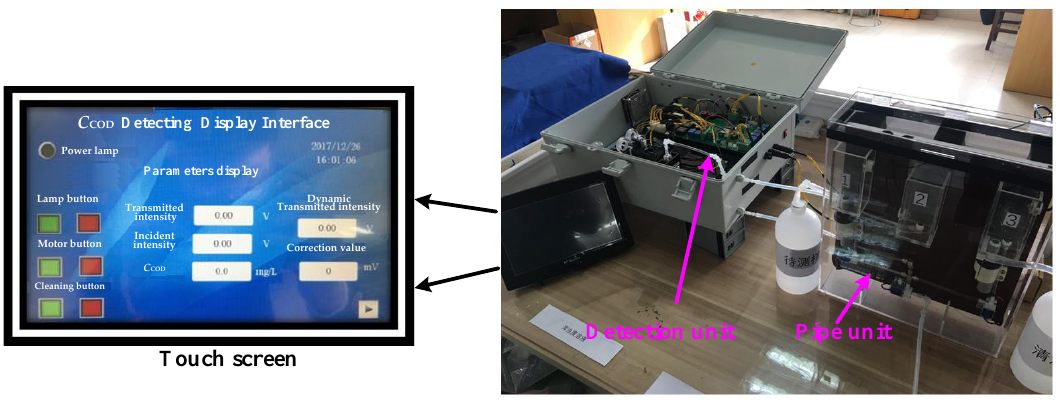
Figure 10. Instrument photograph.